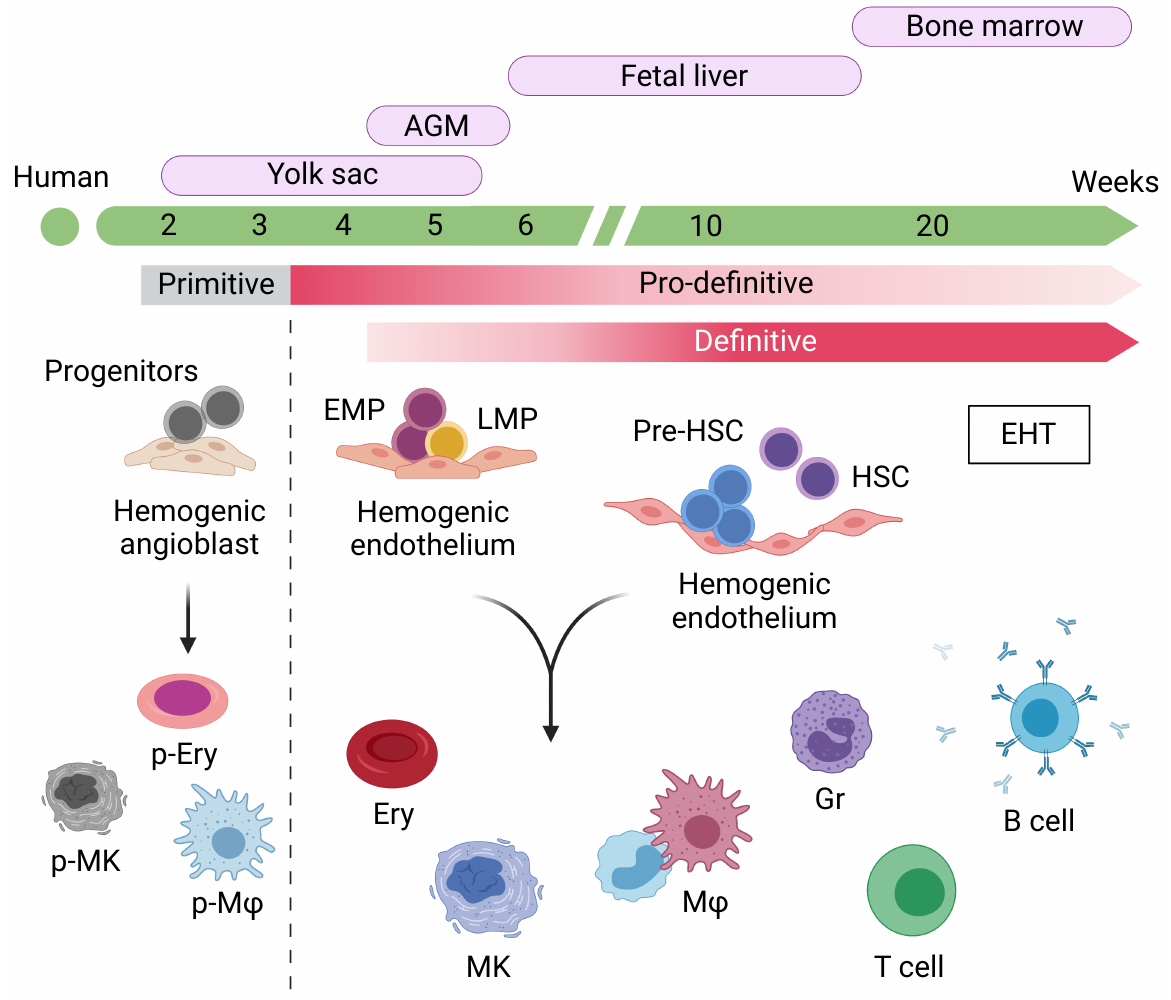
Figure 1. Schematic representation of human hematopoietic development. Embryonic hematopoiesis is established in spatiotemporally overlapping waves, categorized into three main waves termed primitive, pro-definitive, and definitive hematopoiesis. AGM, aorta-gonad-mesonephros; EHT, endothelial-to-hematopoietic transition; EMP, erythro-myeloid progenitor; LMP, lympho-myeloid progenitor; HSC, hematopoietic stem cell; Ery, erythrocyte; MK, megakaryocyte; M ϕ , macrophage; Gr,